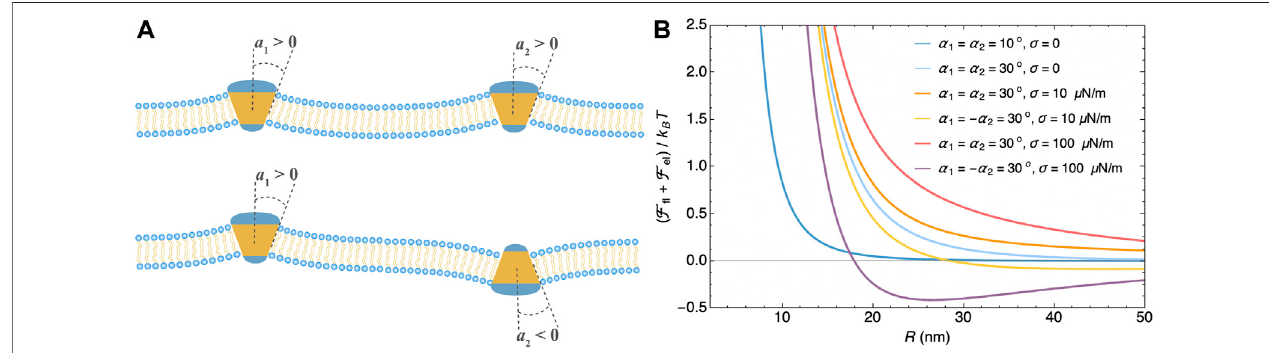
FIGURE 2 | Membrane-mediated interaction between two conical inclusions. (A) Cartoon of membranes with two conical inclusions that have contact angles α 1 and α 2 . (B) Membrane-mediated interaction as a function of the inter-inclusion distance R at different contact angles and membrane tensions calculated from F fl ≈ − 6